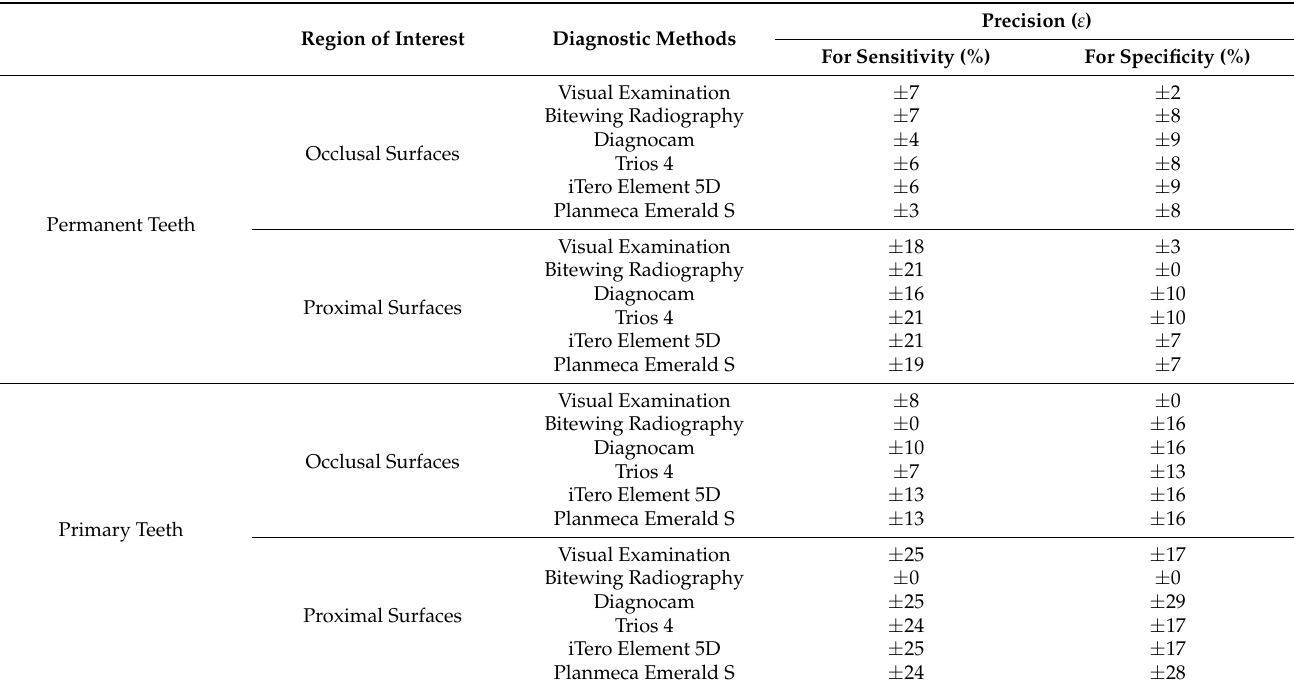
Table A1. Precision of sensitivity and specificity in permanent and primary teeth for the different diagnostic methods (respective gold standard diagnostic method is highlighted in bold